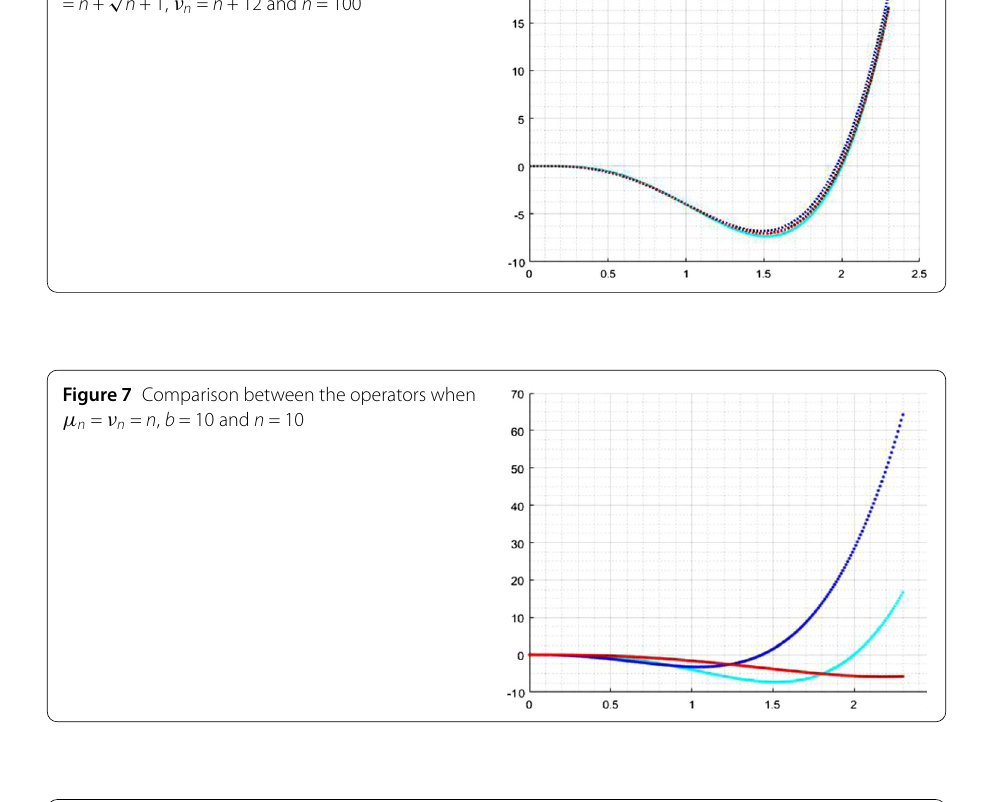
Figure 8 Comparison between the operators when μ n = ν n = n , b = 10 and n =